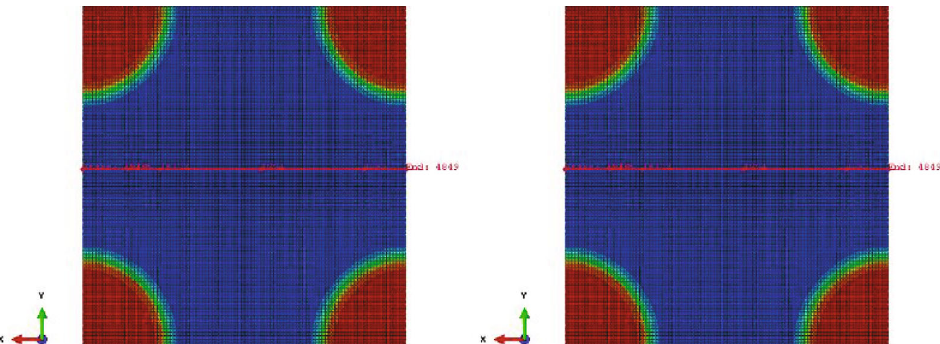
Figure 17: Schematic diagram of path.